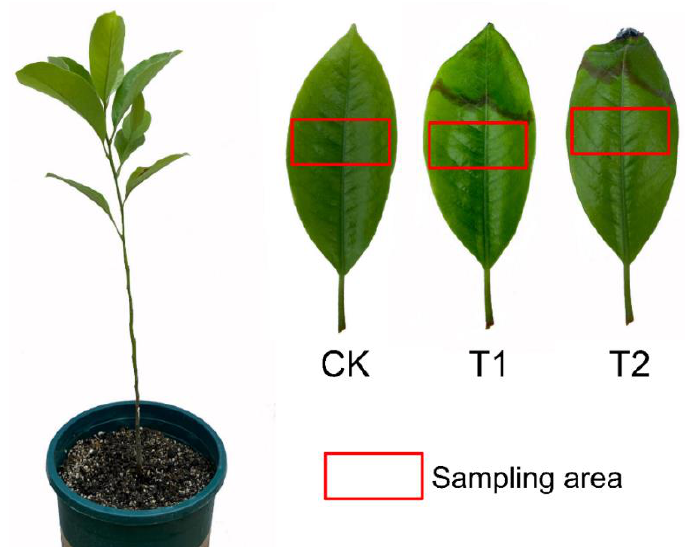
Figure 1. The Michelia macclurei seedling and sampling area after the fire experiment. Left : the characteristic of the seedling. Right : three leaves showed the samples of CK, T1 (slight fire), and T2 (strong fire). The red frames point to the sampling area.